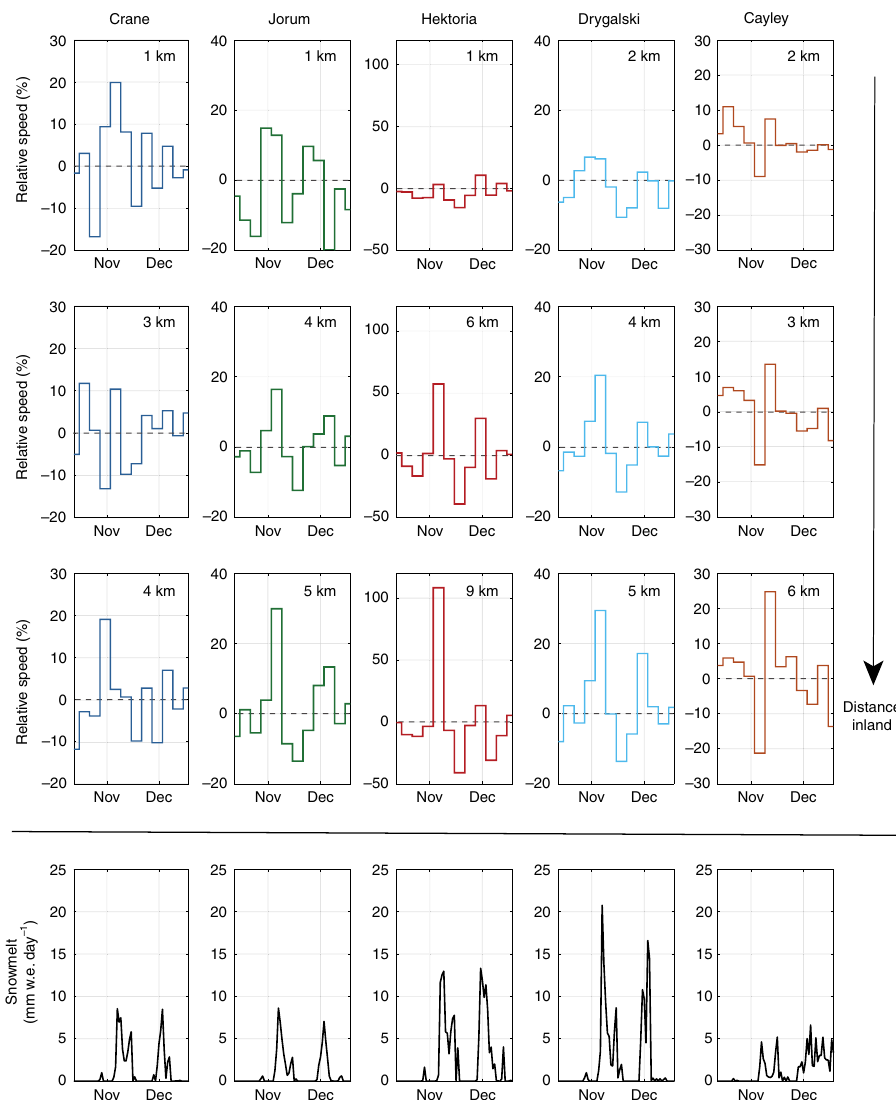
Fig. 3 Relative velocity of studied glaciers during the November 2017 speed-up event. Note how the relative magnitude of the speed-up increases further away from the marine margin. Ice velocity was detrended using a 144-day running mean. Melt rates are mean values for every ROI studied at the respective